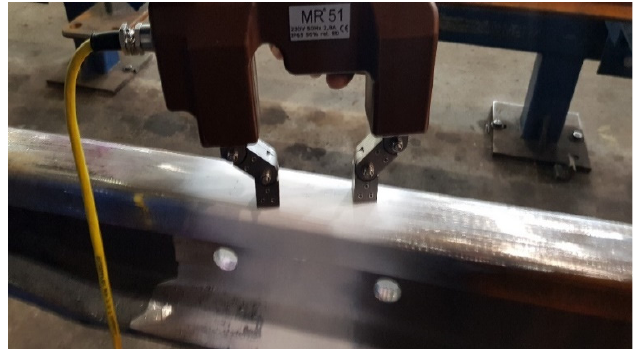
Figure 13. Surface magnetization. Source: own.